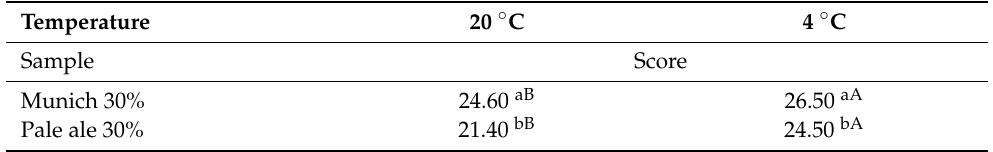
Table 2. Table presenting evaluating scores/acceptance of formulated beverages drank at different